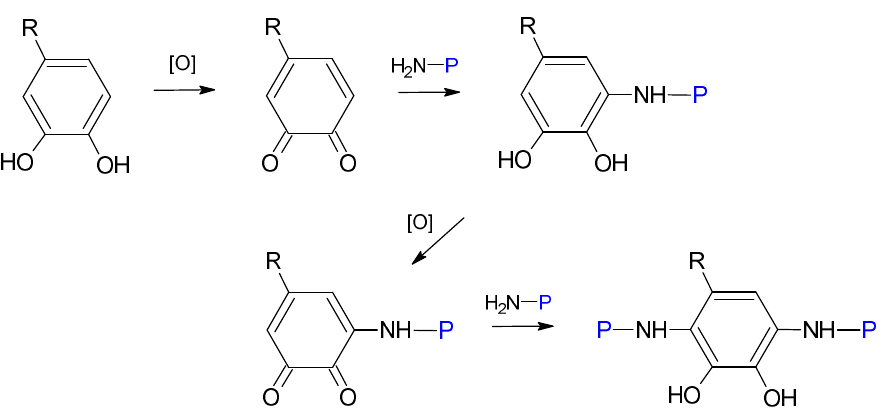
Figure 3. Reactions between a poly-phenolic compound and amine side chains of proteins for cross- linking, where “H2N-P” represents the protein. Modified from the work of